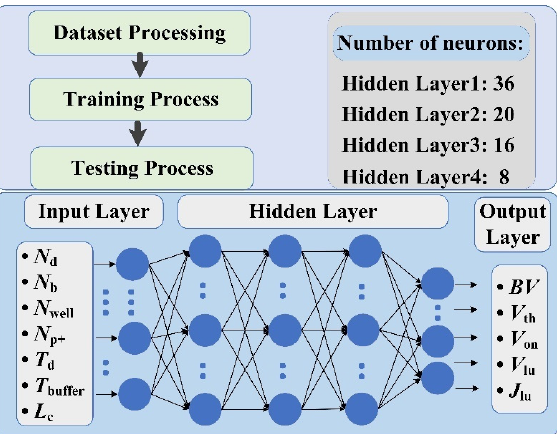
Figure 3. The overall flow and structure of the proposed ANN